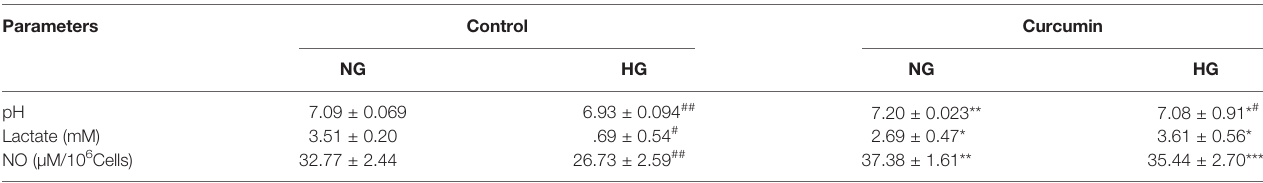
TABLE 2 | Curcumin resisted the high glucose-induced alterations in extracellular lactate, NO, and pH level.